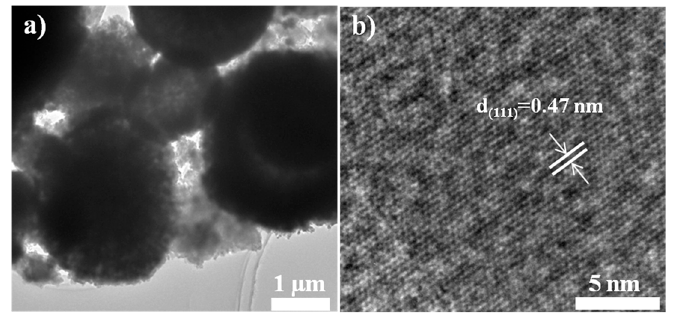
Figure 5. TEM ( a ) and high-resolution TEM ( b ) of S 12 .